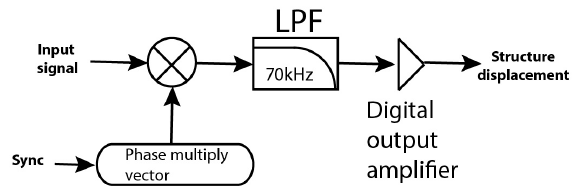
Figure 3. Digital lock-in amplifier logic blocks. (LPF: Low-pass filter).